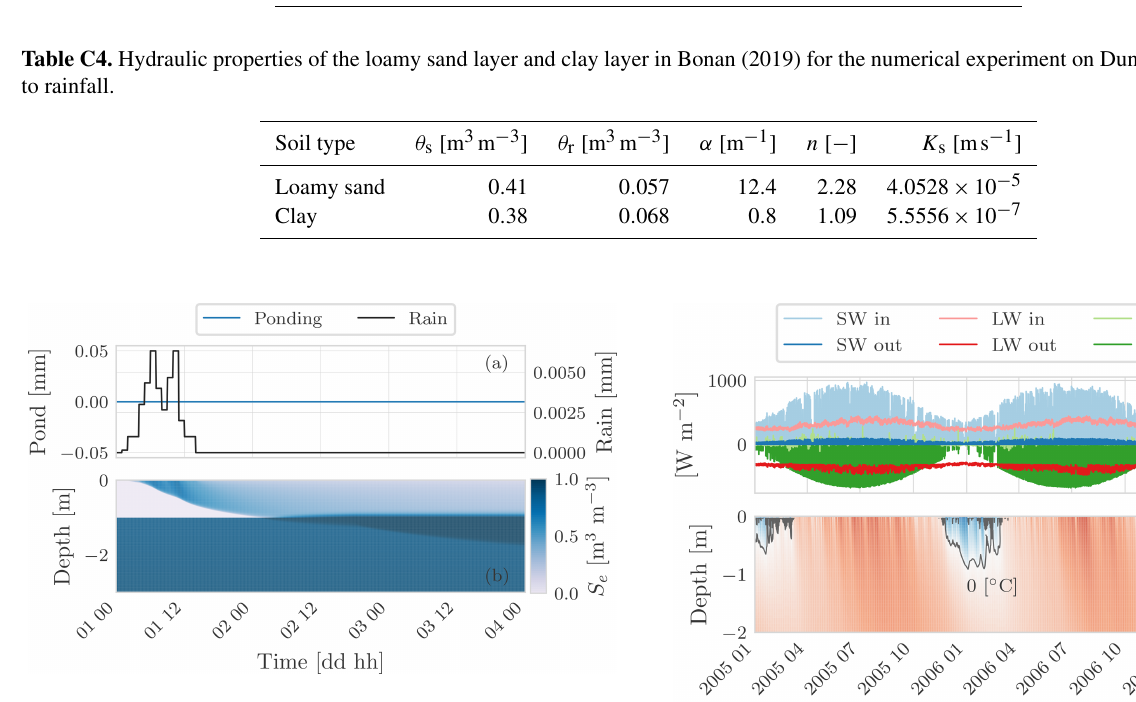
Figure C12. In this numerical experiment there is no saturation ex- cess since the greater thickness of the uppermost layer ensures suf- ficient water storage capacity for the forcing rainfall. Figure D1. Behavioural test case of pure heat conduction in soil